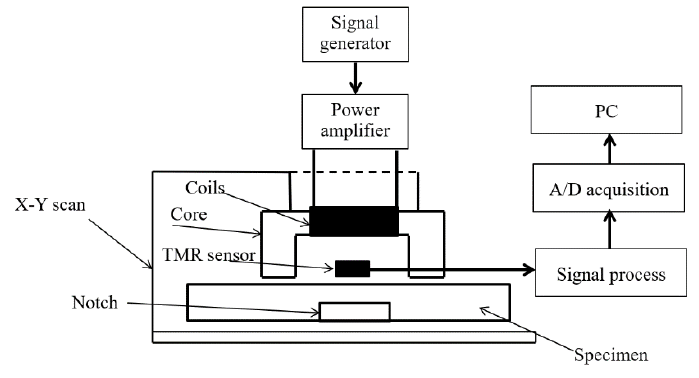
Figure 5. PECT system.